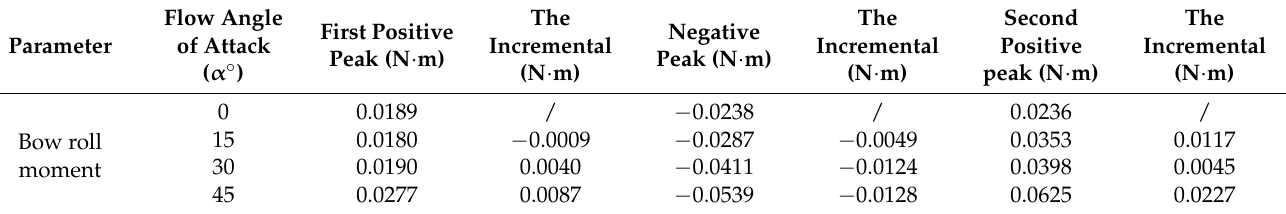
Figure 32. Schematic of bow roll moment and center of gravity position of a ship passing a round- ended pier with different flow angles of attack: ( a ) Bow roll moment; ( b ) Center of gravity position. Table 4. Statistical table of bow roll moment